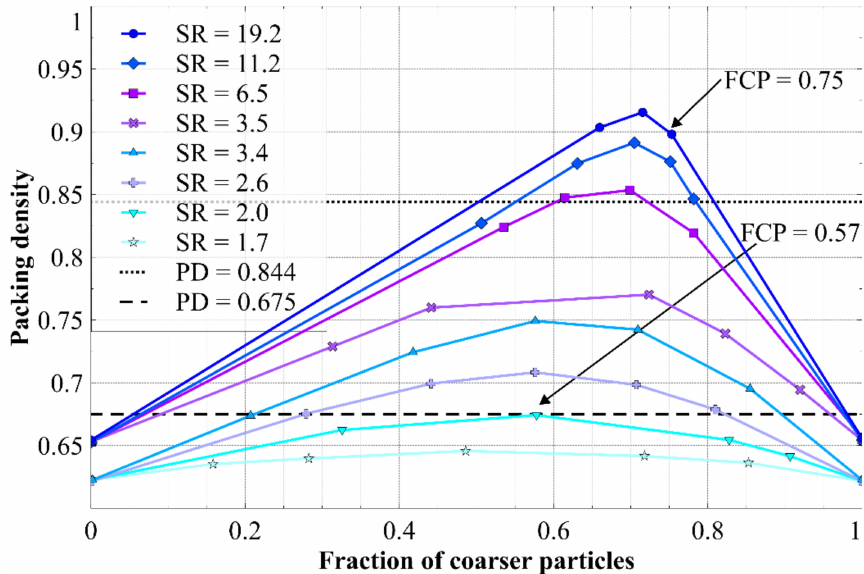
Figure 8. Packing density measured for binary mixtures of spherical particles, showing the effect of size ratio (SR) and the fraction of coarser particles. The horizontal lines show the packing density (PD) of states (b) and (c) from Figure 7. The maximum FCP values that could accommodate these PD values are indicated. Data adapted from